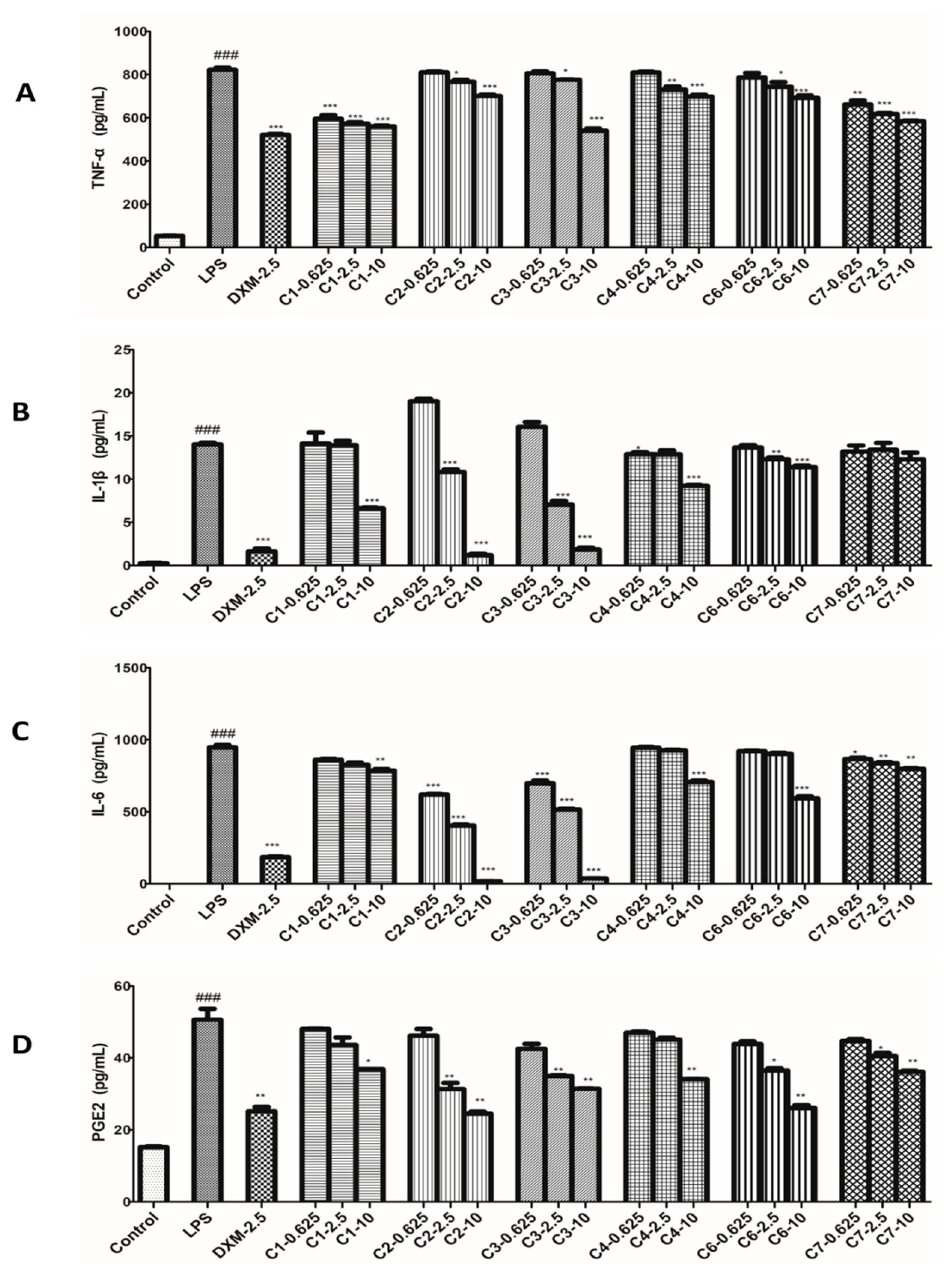
Figure 5. Effects of compounds on the TNF- α , IL-1 β , IL-6 and PGE2 productions in RAW 264.7 macrophages. Cells were pretreated with compounds for 1 h and then stimulated with LPS (1 μ g/mL) for 12 h. The productions of TNF- α ( A ), IL-1 β ( B ), IL-6 ( C ) and PGE2 ( D ) were measured as described in the materials and methods. Data shown represent the mean value ± SD ( n = 3). ### p < 0.001 when compared with control versus LPS; *** p < 0.001, ** p < 0.01, * p < 0.05 as compared to the group treated with LPS alone.